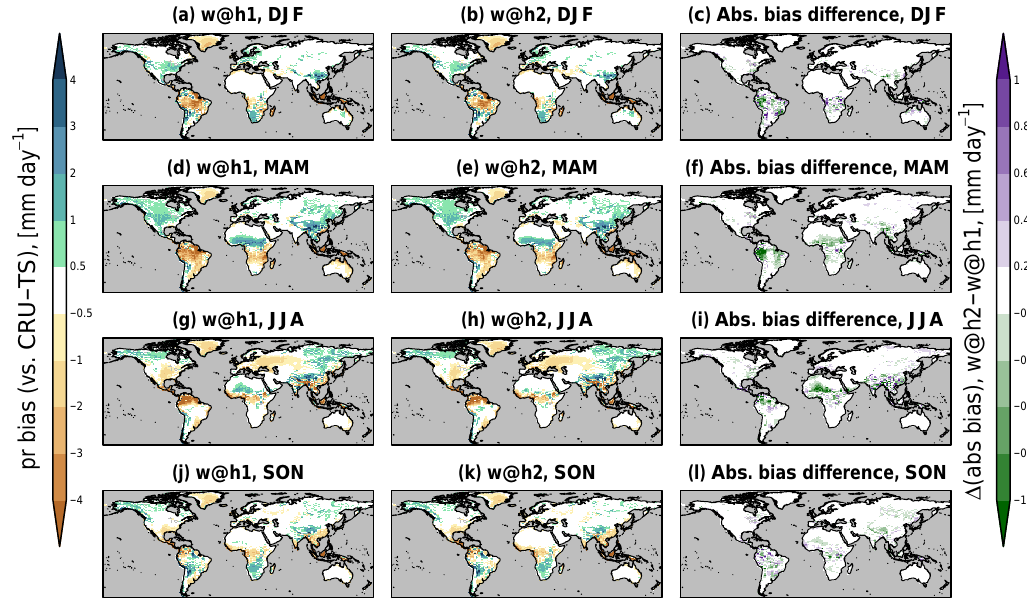
Figure 3. Same as Fig. 2 but for precipitation, in mmday − 1 .